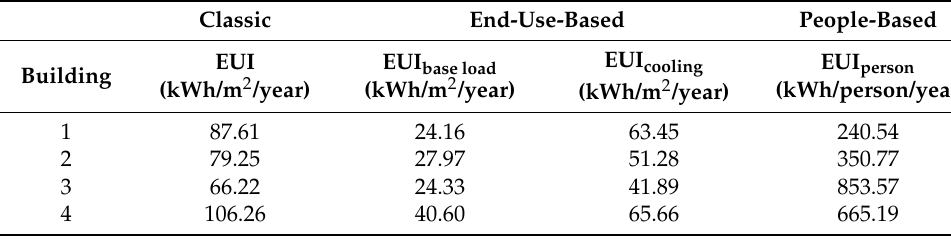
Figure 7. EUI disaggregated by end-use: ( a ) Building 1, ( b ) Building 2, ( c ) Building 3, and ( d ) Building 4. Table 7. Results from the three proposed